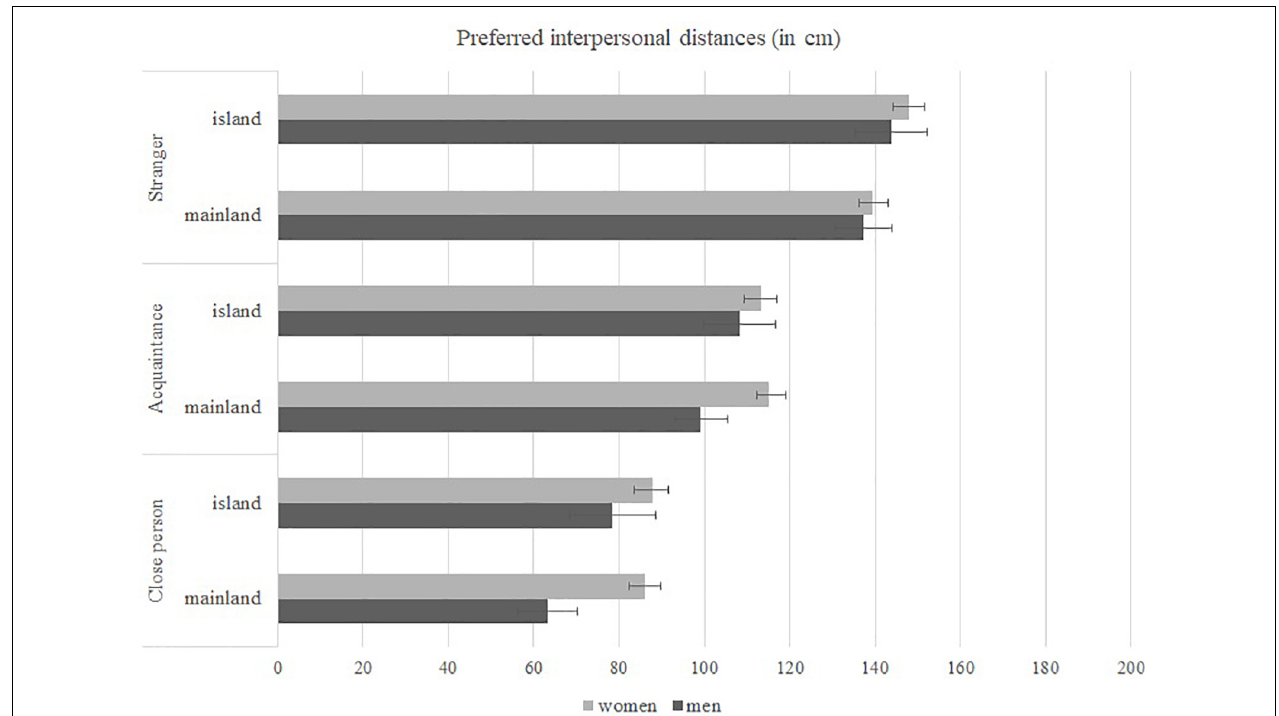
FIGURE 1 | Preferred interpersonal distances (in cm) as a function of geographical location (island vs. mainland) and